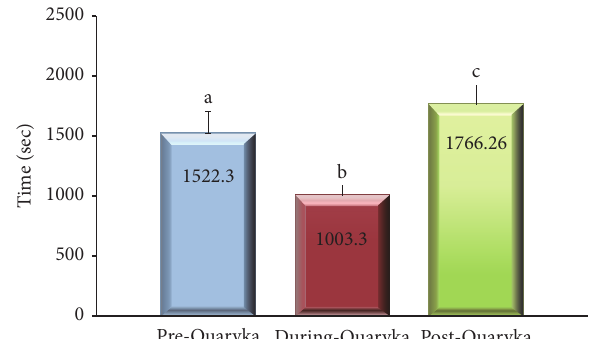
Figure 4: Cribbing group: cribbing behaviour observed during the three phases of the study. Bars with different superscripts differ significantly ( 𝑃 < 0.05